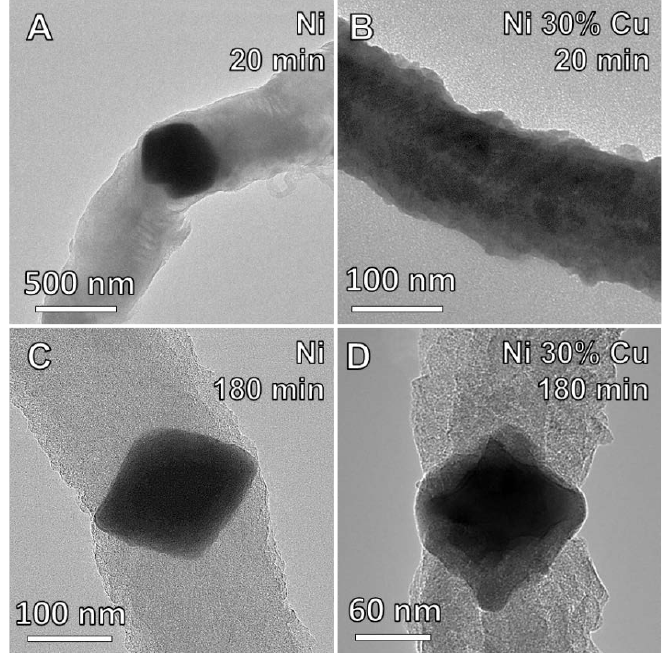
Figure 6. Carbon nanofibers deposited at 550 °C with C 2 H 4 and H 2 (4:1) using ( A ) Ni milled for 20 min; ( B ) Ni 30 at % Cu milled for 20 min; ( C ) Ni milled for 180 min; and ( D ) Ni 30 at % Cu milled for 180 min.